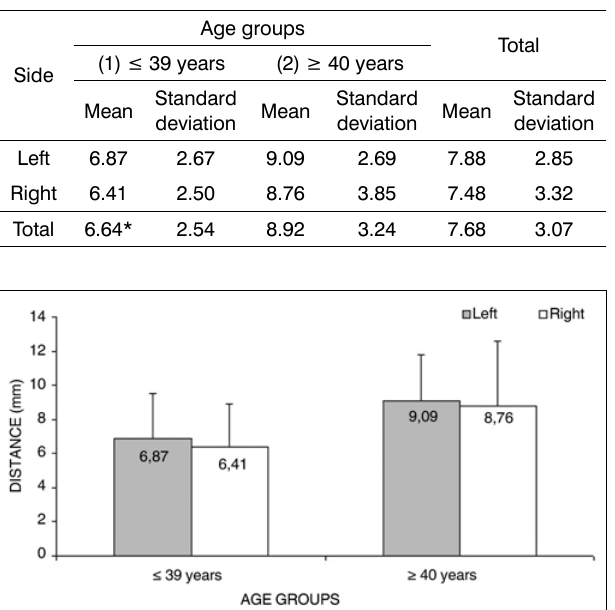
Table 4. Measurement 1 relative to age and side, in mm, ex-